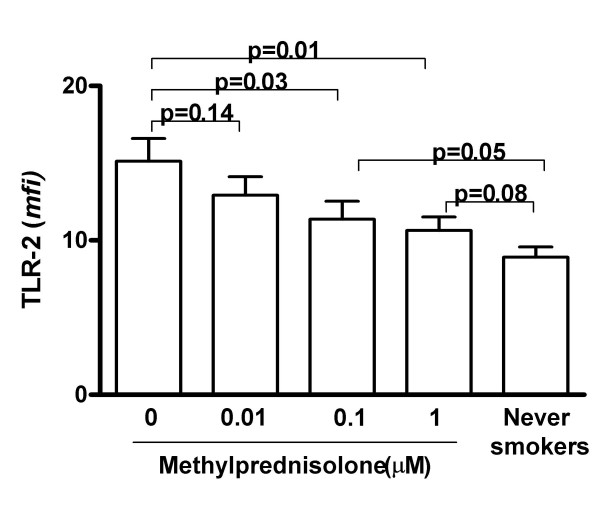
Effect of methylprednisolone on the expression of TLR-2 by monocytes from AECOPD patients (5 different patients; purified cells from each subject were tested in duplicate for each condition studied). Purified monocytes were incubated for 3 h with different amounts of methylprednisolone and TLR-2 expression was studied by flow cytometry. For statistical comparisons, TLR-2 expression by monocytes from 5 representative never smokers after 3 h culture without stimuli is included in the figure. The results were analyzed by one-way analysis of variance with Bonferroni contrasts.